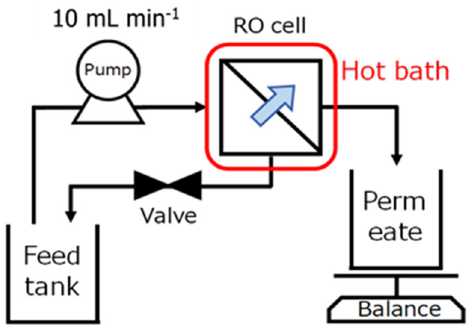
Figure 2. Schematic illustration for RO filtration apparatus.